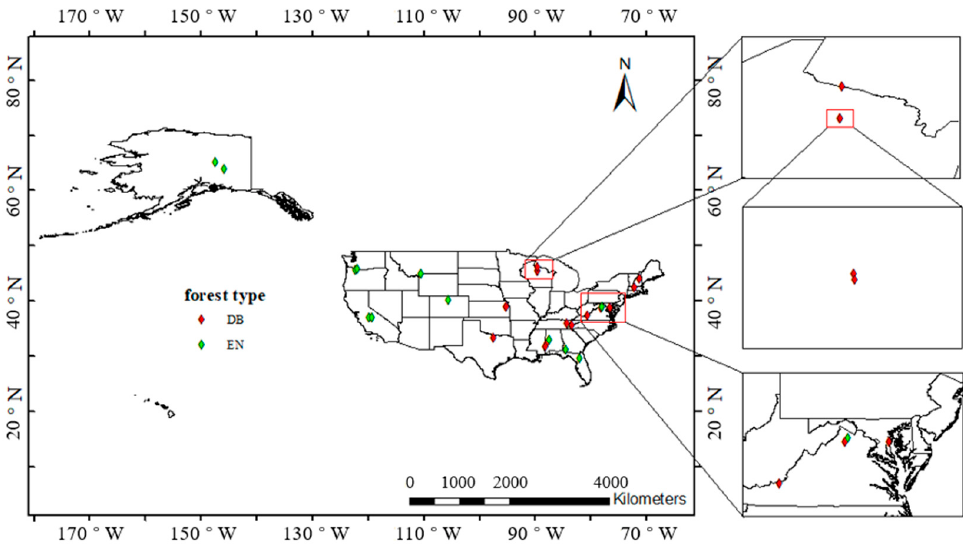
Figure 1. Map of the US and study sites. DB: deciduous broadleaf forest, EN: evergreen needleleaf forest.